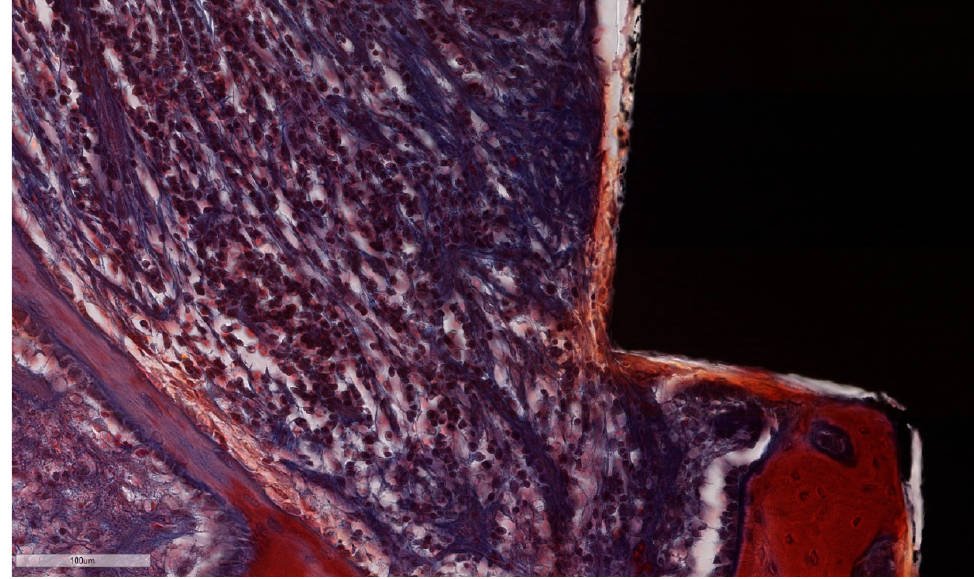
Figure 13. ICT in direct contact with the implant surface, without an interposed epithelial lining. Note the abundant lympho-plasmocytic infiltrate, which progresses inside the bone marrow, the thin bone trabeculae left after remodeling along with prominent osteoblast rim (implant #3, MGA, bar measure is 100 µm).